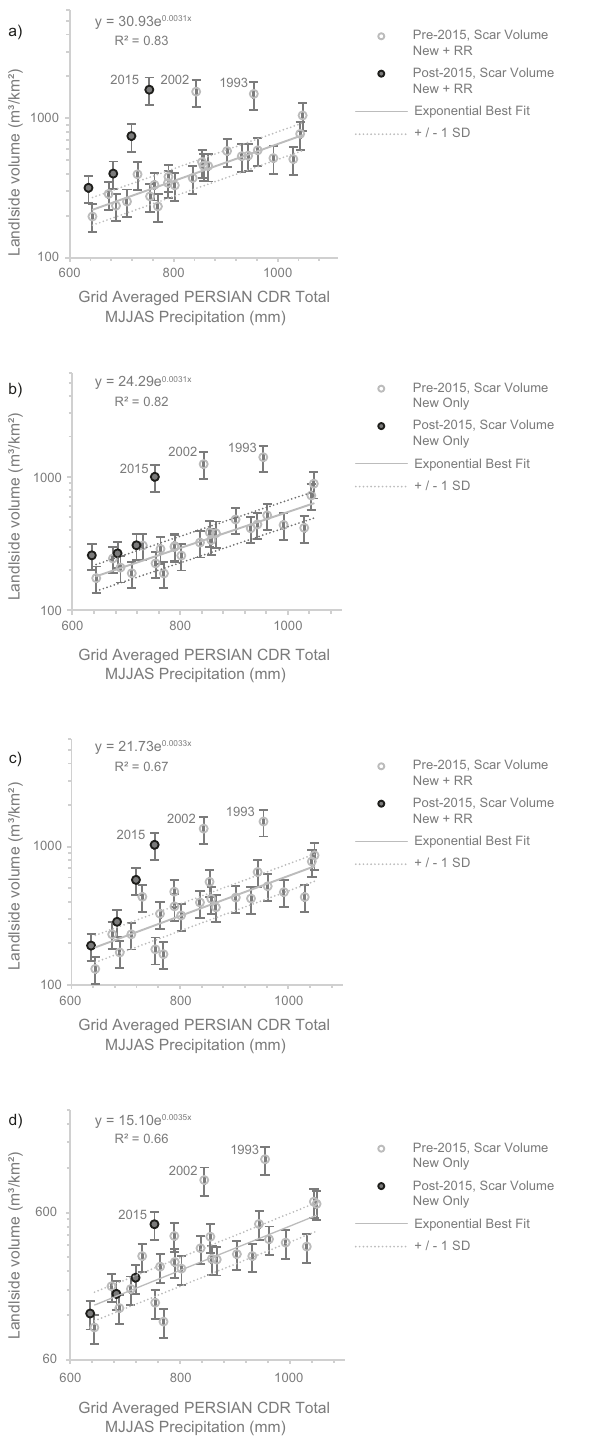
Fig. 2 Empirical relationships between measures of mass-wasting volume and monsoon strength across central-eastern Nepal. a – d Empirical relationships between measures of mass-wasting volume (m 3 /km 2 ) and PERSIANN-CDR total MJJAS precipitation for a total ‘ New + RR ’ volume, b total ‘ New Only ’ volume, c scar ‘ New + RR ’ volume and d scar ‘ New Only ’ volume. e – h Empirical relationships between measures of mass-wasting volume (m 3 / km 2 ) and APHRODITE total MJJAS precipitation >25 mm for e total ‘ New + RR ’ volume, f total ‘ New Only ’ volume, g scar ‘ New + RR ’ volume and h scar ‘ New Only ’ volume. Where, in all cases ‘ New + RR ’ refers to the combined volumes of both new failures and reactivations/remobilisations and ‘ New Only ’ refers to just the volumes of new failures, with reactivations and remobilisations excluded. The exponential best fi ts shown on these graphs apply to the non-anomalous pre-2015 points only, with all anomalous points labelled individually. The post-2015 points are also shown for reference, as are the ±1 standard errors on the best- fi t